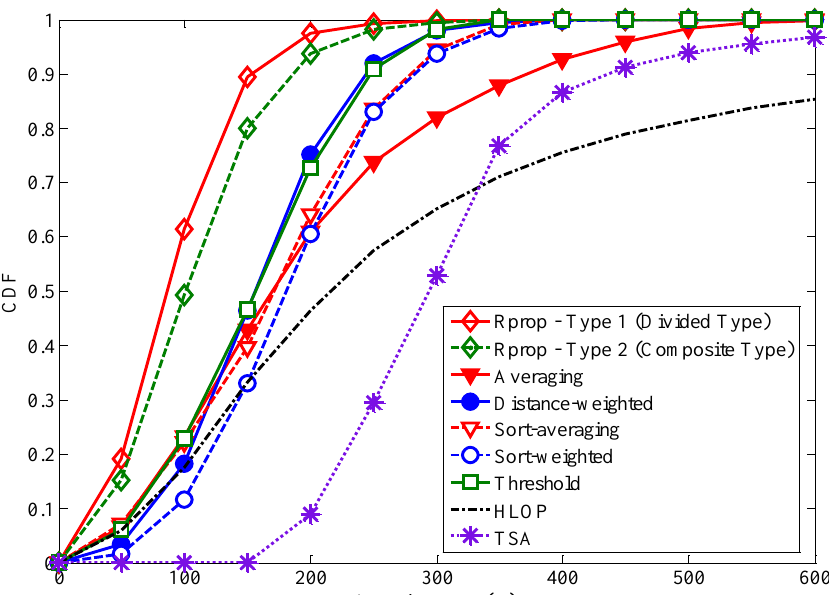
Figure 11. Comparison of location error CDFs with biased uniform random